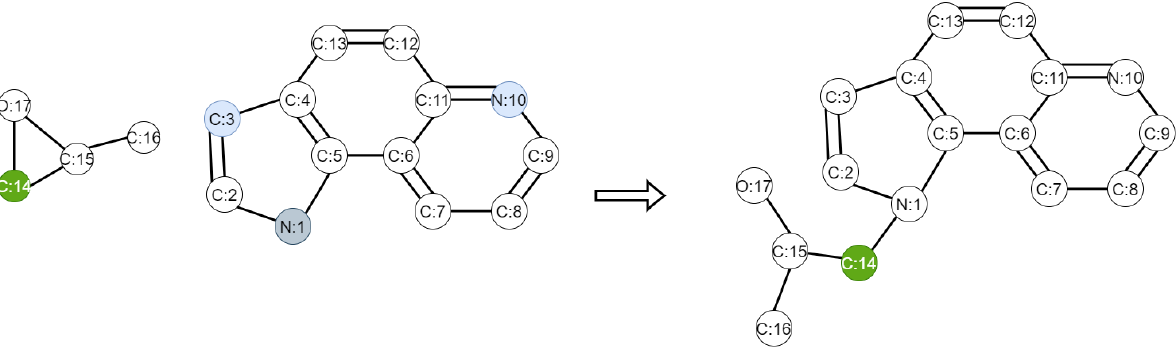
Figure 3. Propylene oxide reaction with pyrroloquinoline. The C, N, O in the figure represent chemical element symbols corresponding to Carbon atom, Nitrogen atom, and Oxygen atom, and the number followed denotes atom